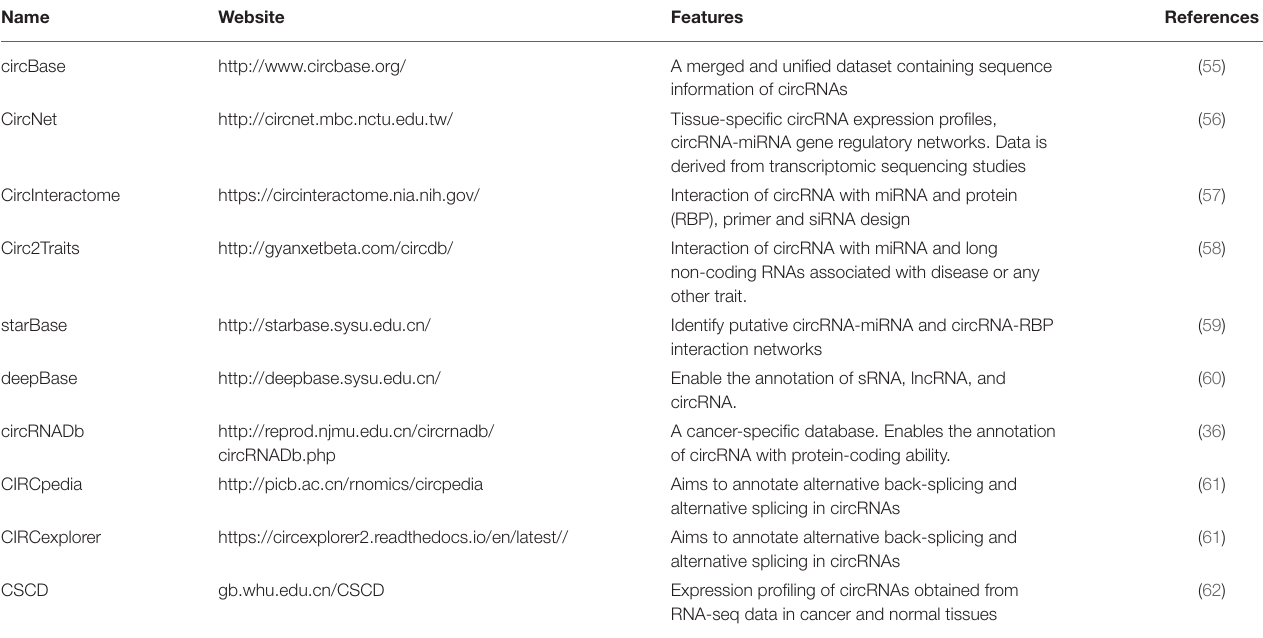
TABLE 2 | Most commonly used databases containing circRNA-related